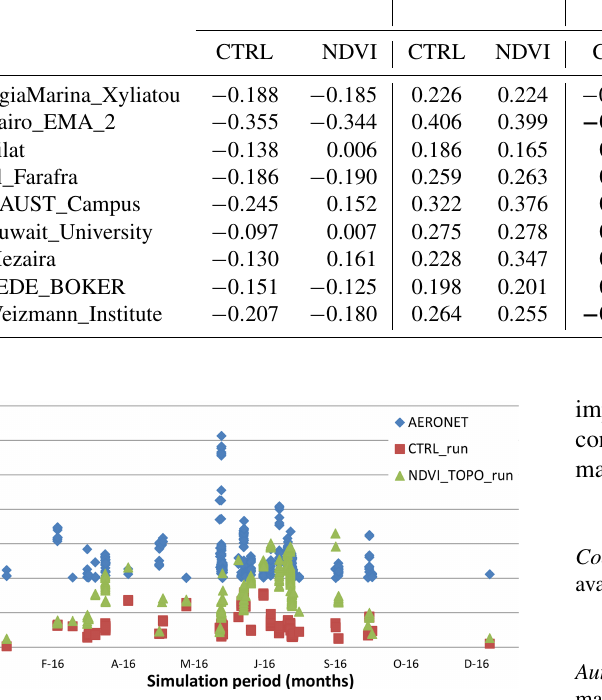
Table 2. Statistical metrics from the annual runs (2016) at AERONET stations. Bold values indicate a correlation coefficient with p < 0 . 01. Station